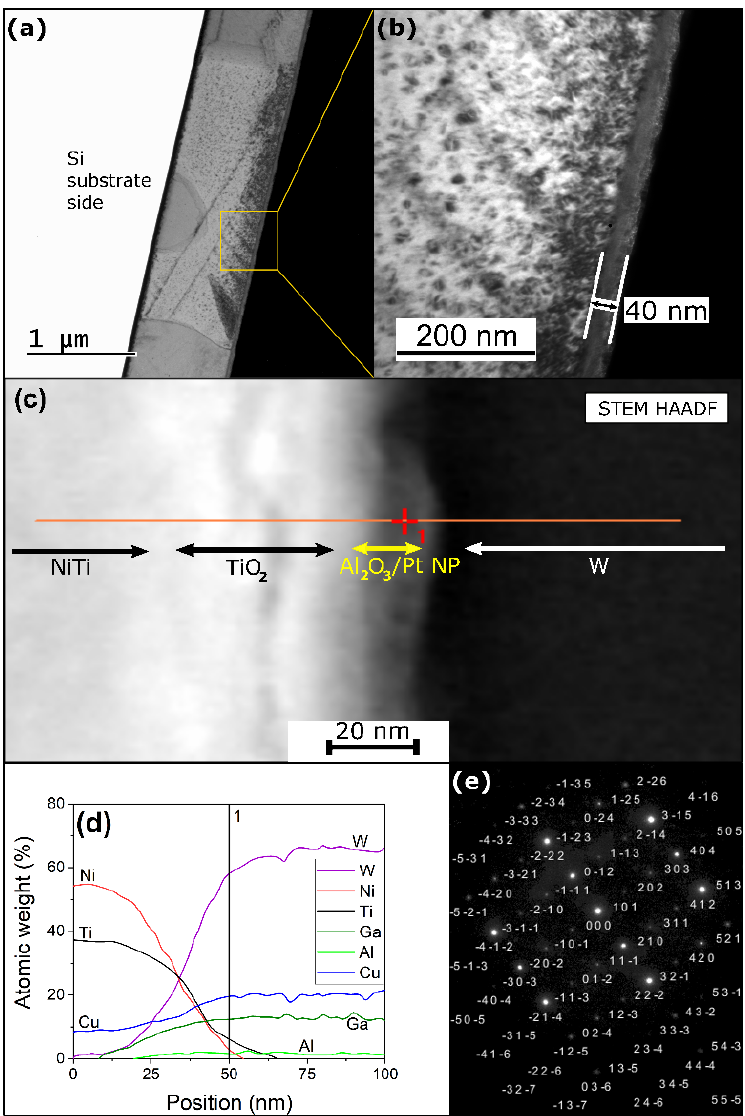
Figure 3. The TEM cross-sectional micrograph of sample Pt100 taken in the bright field (BF) TEM mode ( a – b ), high-angle annular dark-field scanning transmission electron microscopy (HAADF STEM) mode ( c ), EDS line scans close to the NiTi top surface, however the tungsten layer is not a part of the sample ( d ), and the diffraction pattern (corresponding to the R-phase) taken from the SAED (selected area electron diffraction) inside of a NiTi grain ( e ).